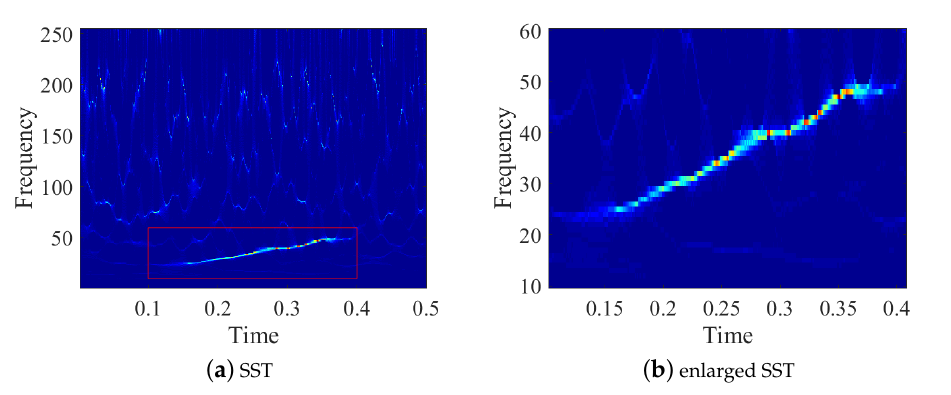
Figure 7. SST and enlarged